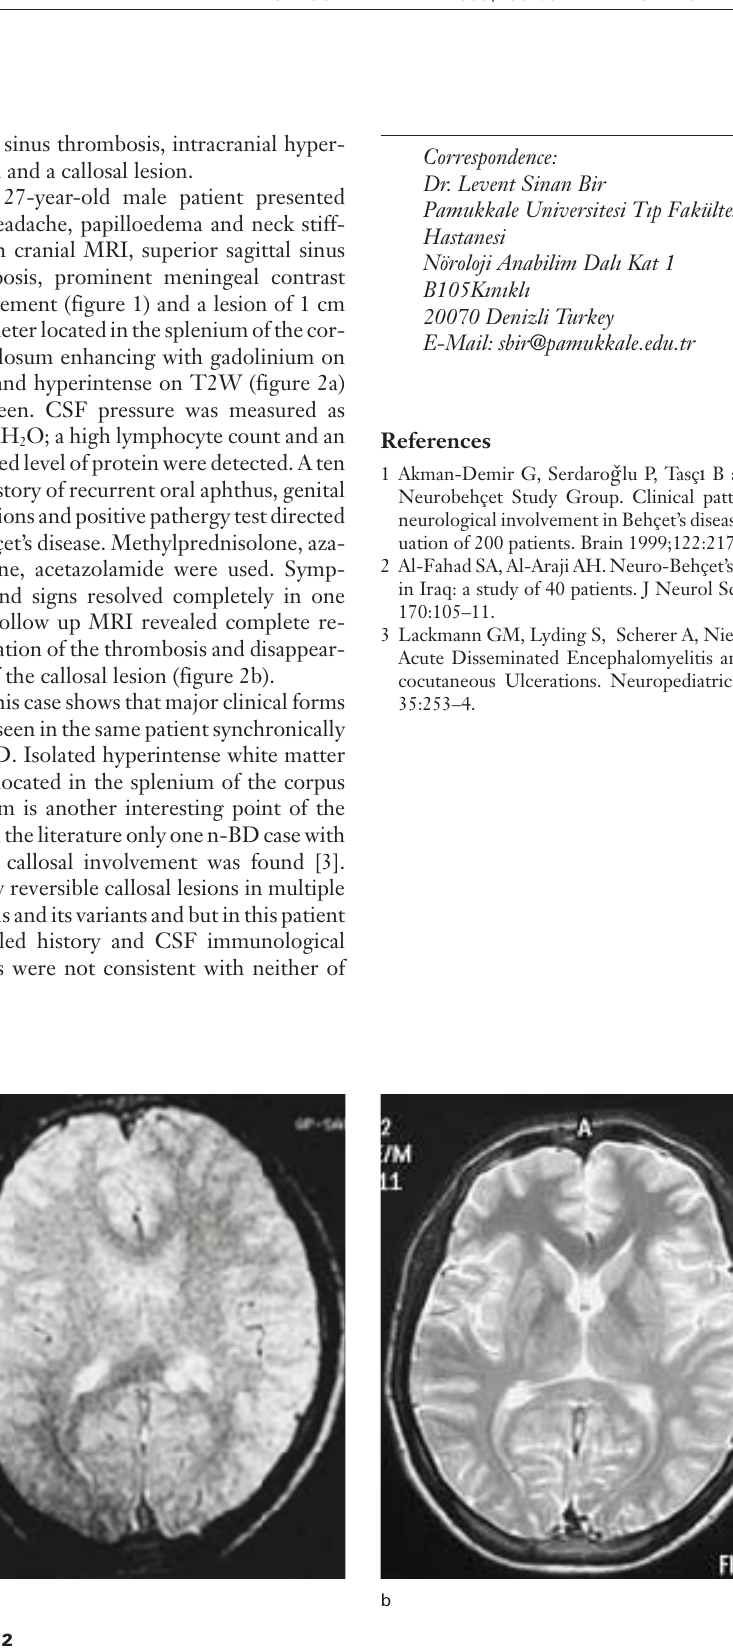
T1 SE post-contrast image shows the contrast enhancement of meninges and saggital sinus thrombosis.